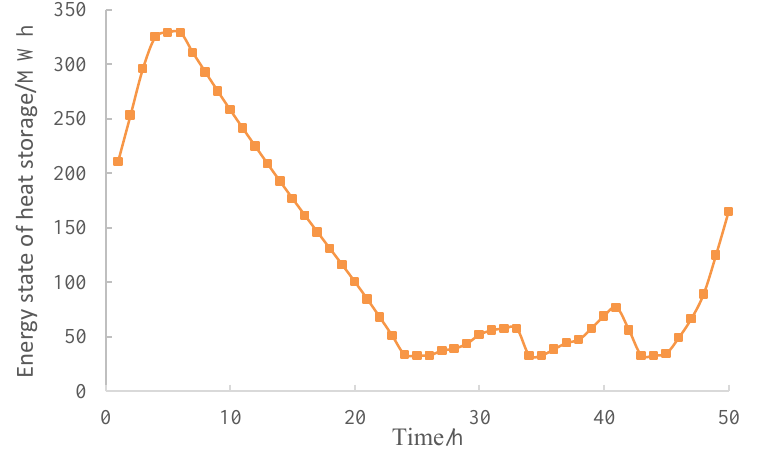
Figure 9. Energy state of TES.